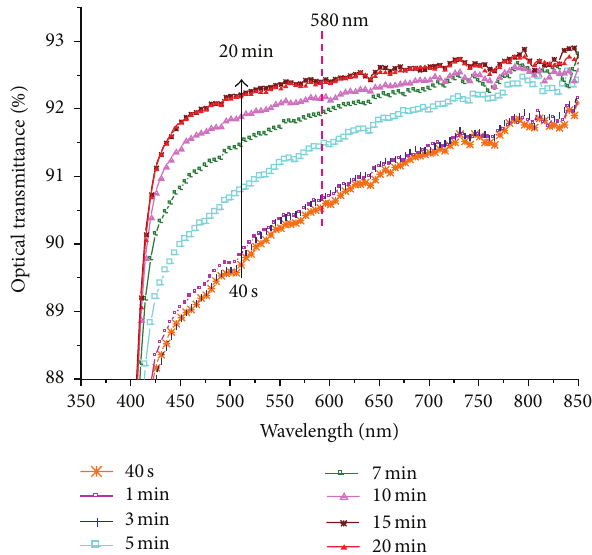
Figure 4: Transmittance versus lamination time at the lamination temperature of 150 ∘ C.